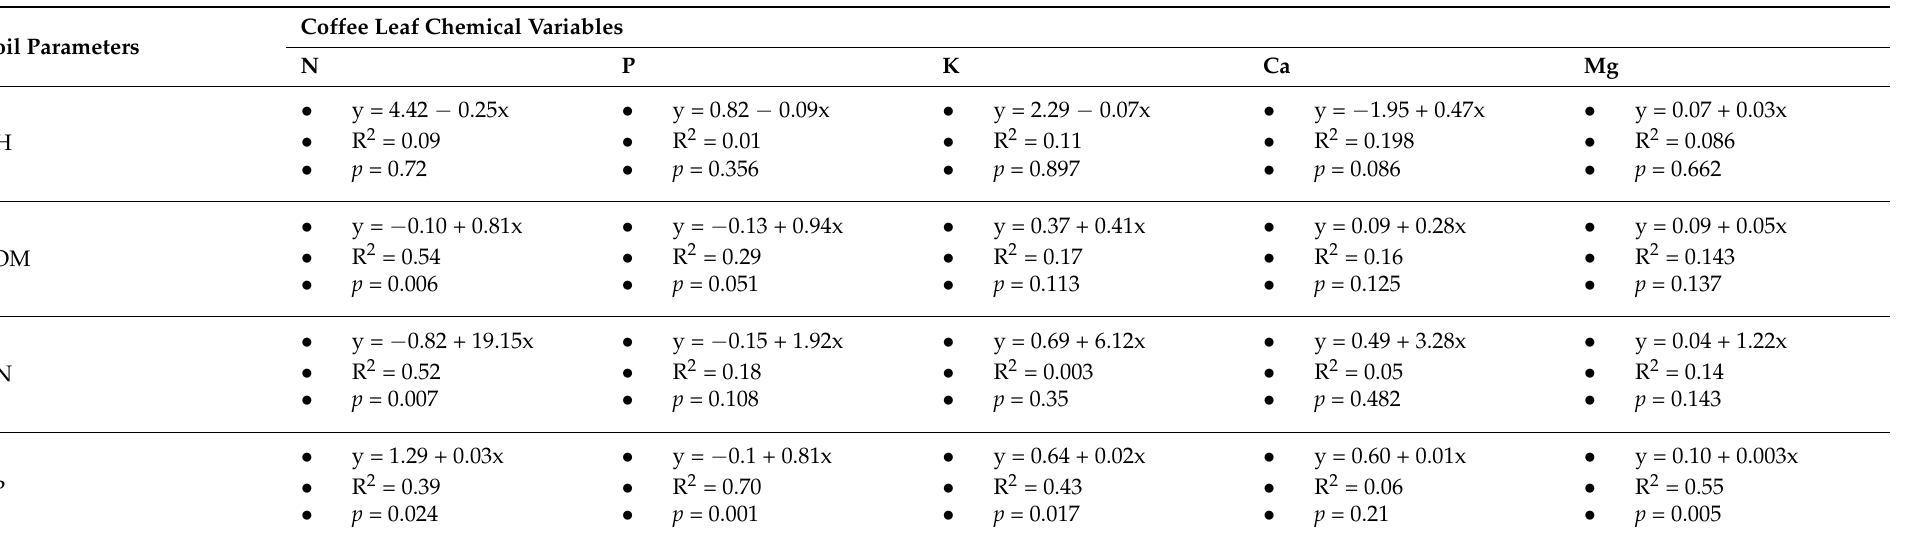
Table 7. Coefficients of determination (R 2 ) and regression models for relating soil and coffee leaf chemical